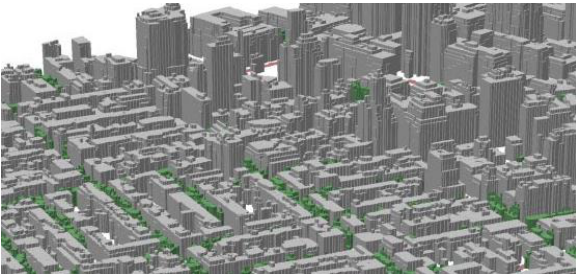
Figure 3. Automatically reconstructed building models of Manhattan area using CNN (Agoub et al., 2019) Based on a Y-shaped CNN (Y-Net), a modern DL-based framework was proposed by Alidoost et al. (2020) for automatic detecting, localizing, and estimating building